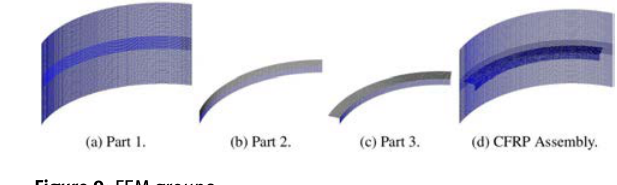
Figure 9: FEM groups.